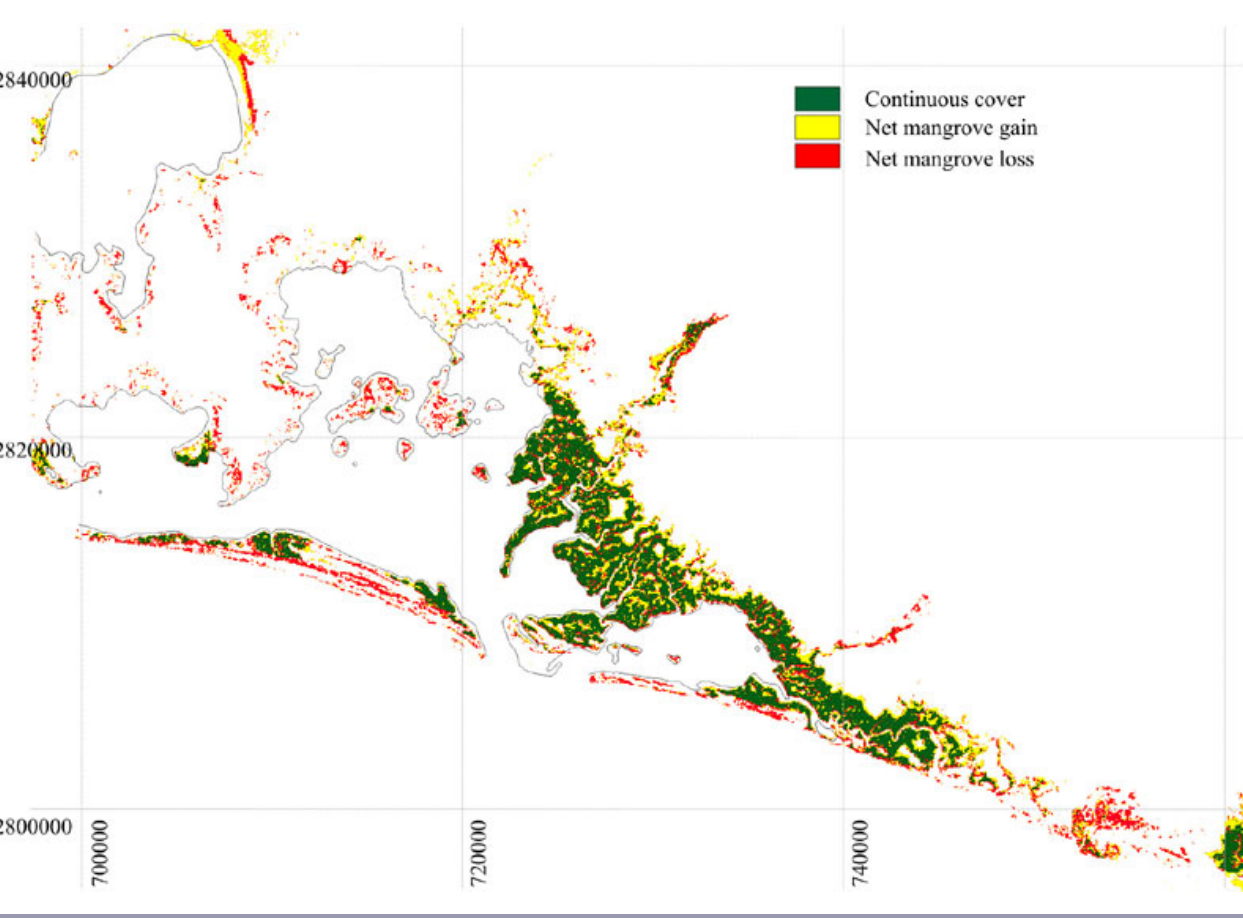
Fig. 3. Thematic map for the Navachiste-San Ignacio-Macapule lagoon complex, representing the mangrove cover changes from 1973 to